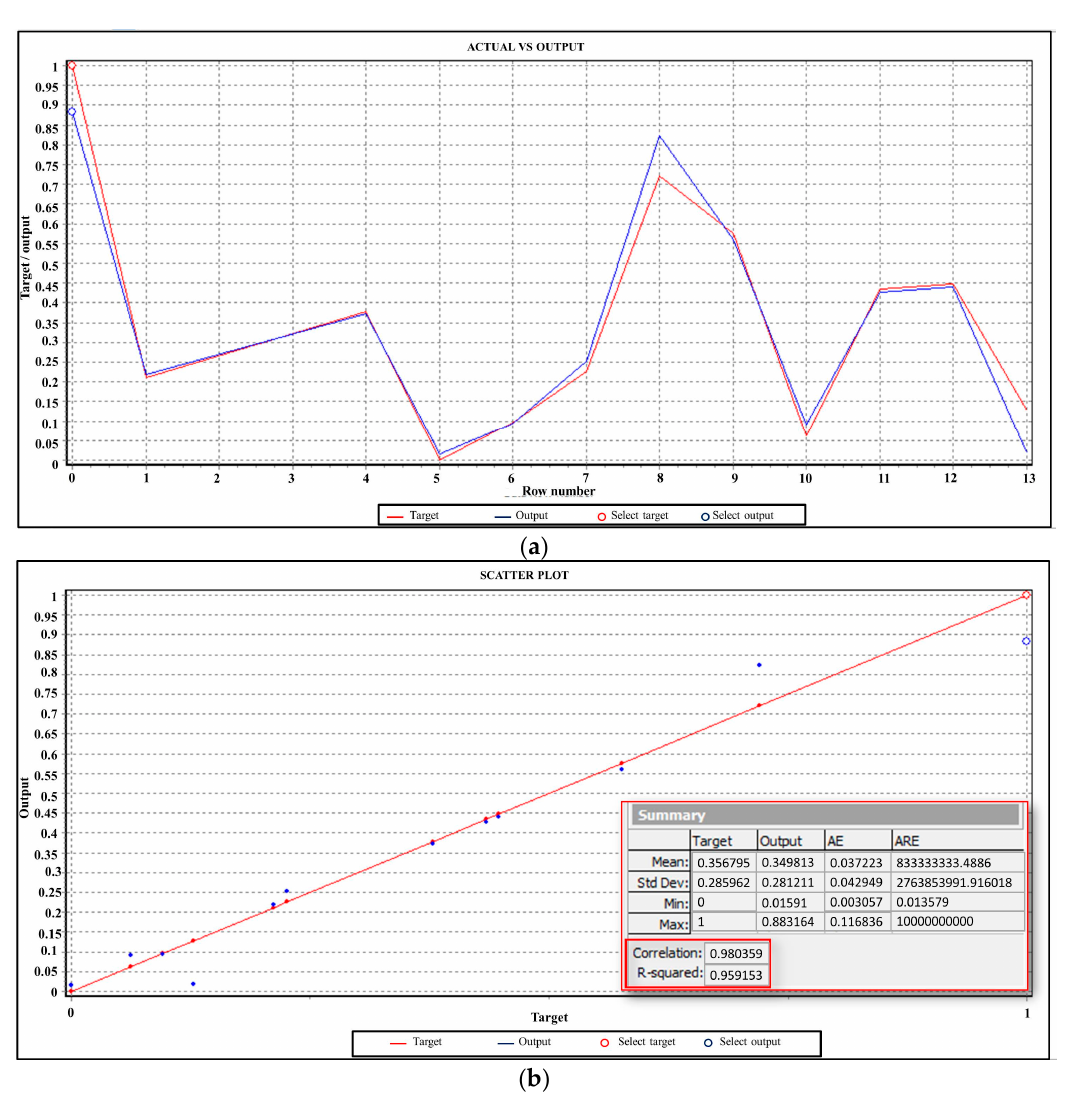
Figure 9. Simulation results: ( a ) Predicted Ultimate Tensile Strength by ANN versus the experimental data; and ( b ) regression line at the training stage.